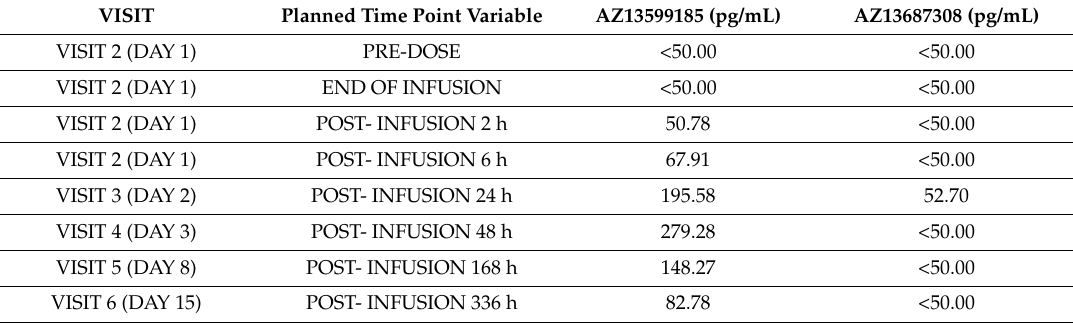
Table 9. Representative pharmacokinetic (PK) data. Data for AZ13599185 and AZ13687308 from a representative subject (ID# 20016160003).